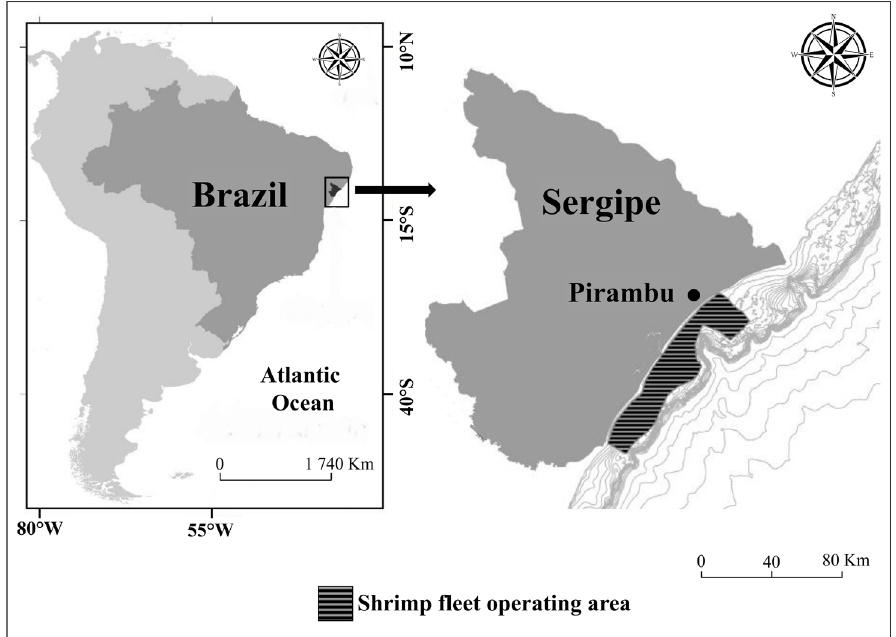
Figure 1. Study area off the state of Sergipe (northeastern Brazil), indicating the location of the municipality of Pirambu and the shrimp fleet operating